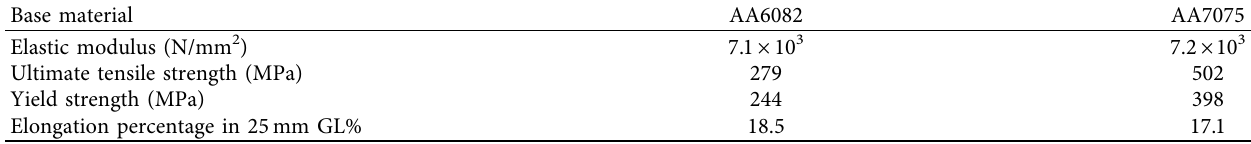
Table 1: Mechanical properties of base material AA6082-AA7075 aluminum alloy.